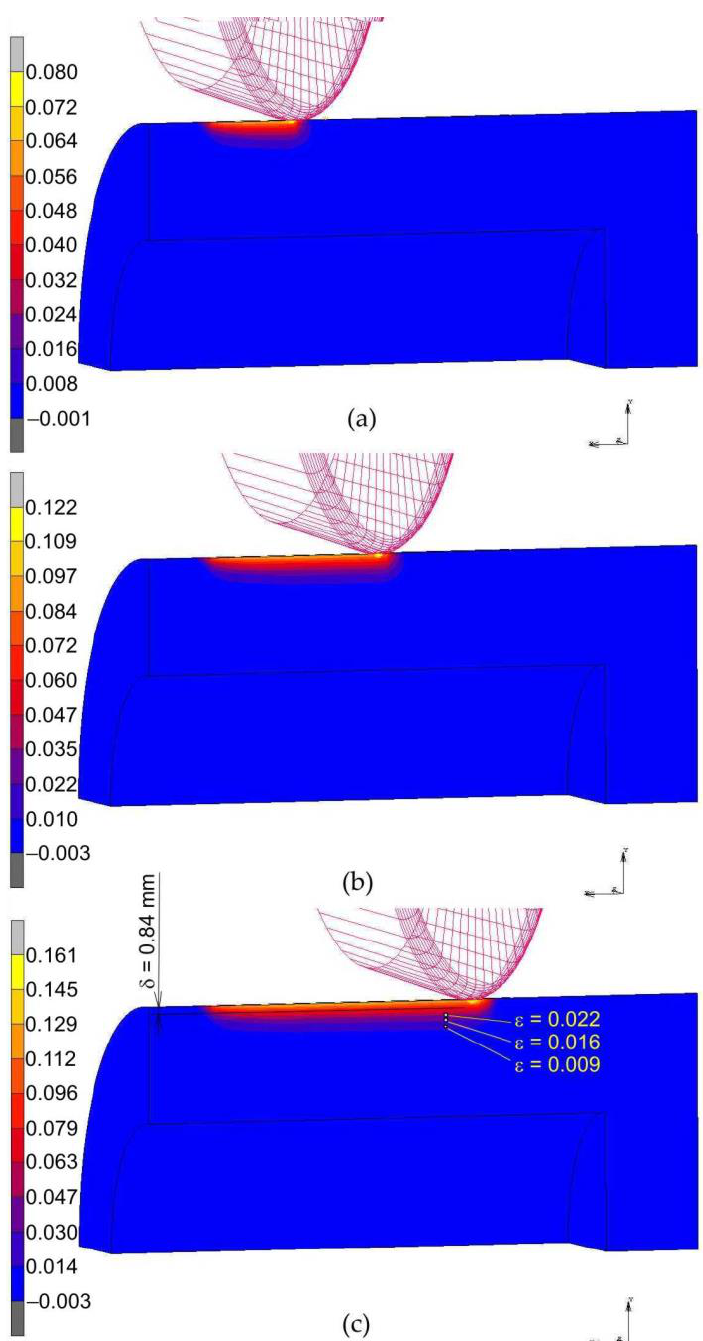
Figure 16. Distribution of equivalent plastic strain ε after roller burnishing with braking moment across the width of the rings packet: ( a ) 10 mm, ( b ) 20 mm and ( c ) 30 mm.